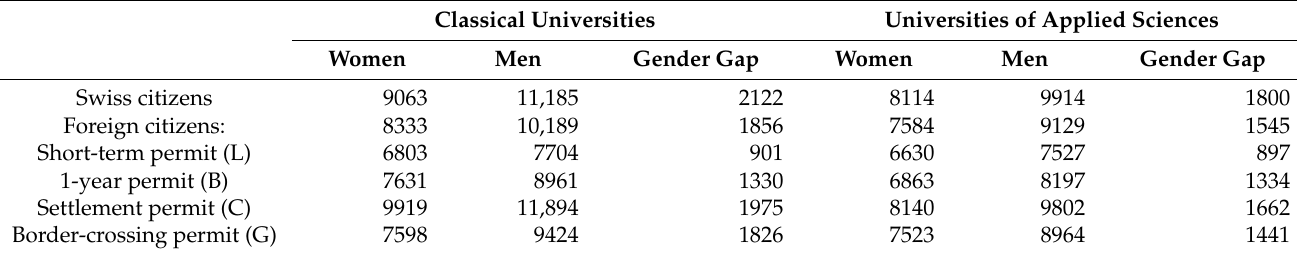
Table 3. Gross Monthly Salary for Swiss and Foreign Citizens *, by Type of University and Gender, Including both Private and Public Sectors, Switzerland, 2018.